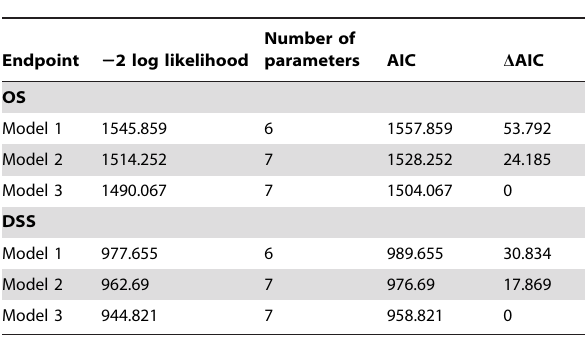
Table 7. Akaike information criterion (AIC) calculations for the OS and DSS multivariate models with or without the SLC6A4